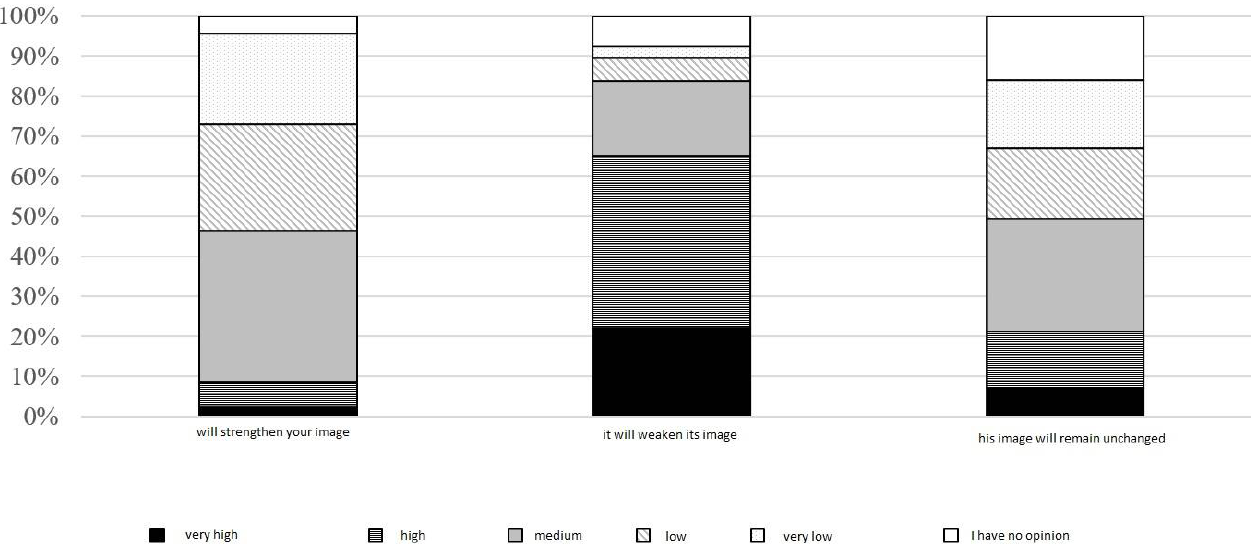
Figure 7. Assessment of the role of various means supporting image building. Source: authors’ own elaboration. In the case of most media, i.e., the Internet, social media, press, radio, respondents most often marked a value of 5 on a scale of 1–10, and the average oscillated between 5 and 6. Perhaps surprisingly, the highest average in this group was obtained for social